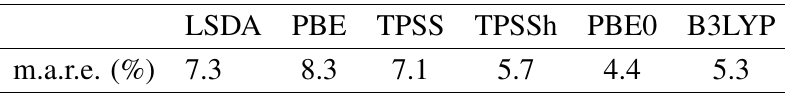
Table 9. The same as Table 2, but for pyridine (C